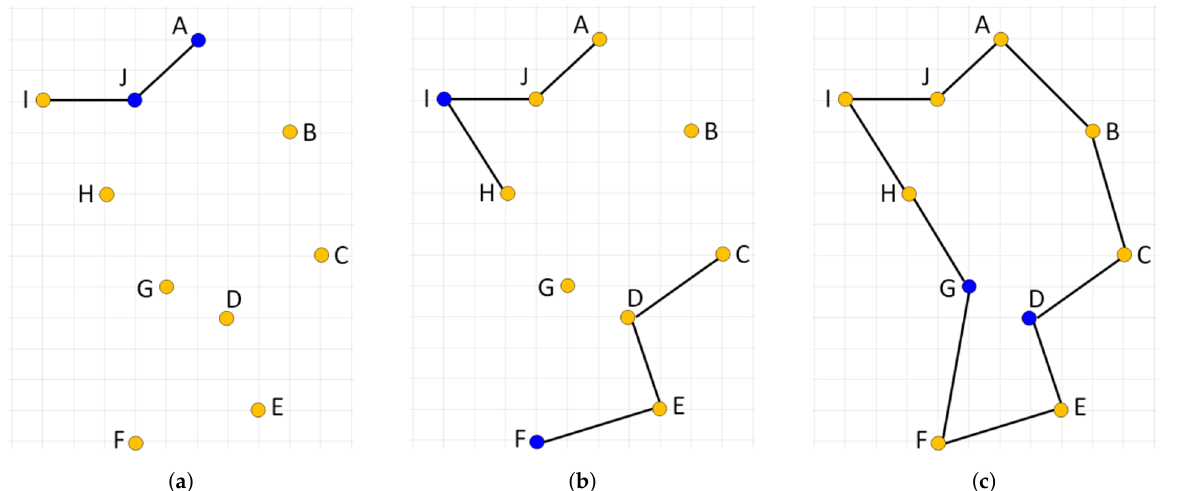
Figure 6. Extended nearest neighbor constructive procedure applied to cities in the following order AJCEIFBHGD . ( a , b ) show a partial solution after processing nodes {A, J} and {A, J, C, E, I, F}, respectively. ( c ) shows the final solution. The last two nodes linked into the solution in the given stage of the construction process are shown in